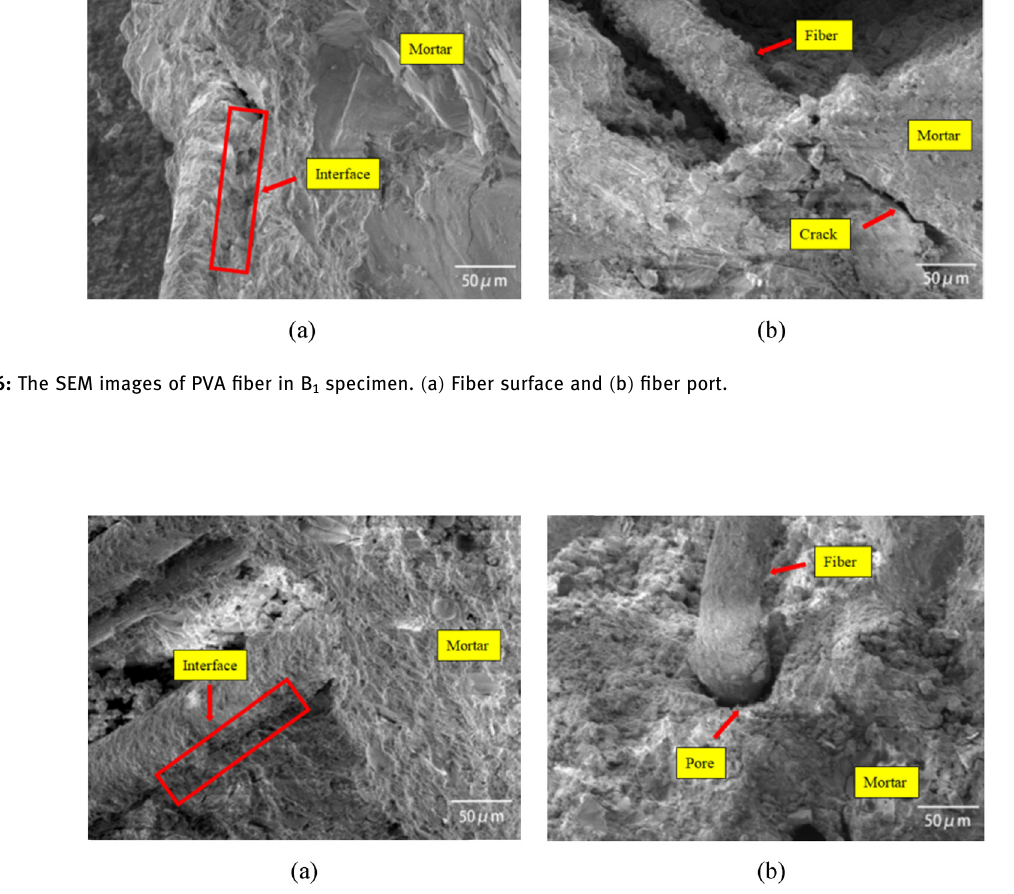
Figure 7: The SEM images of PVA fi ber in O 1 specimen. ( a ) Fiber surface and ( b ) fi ber